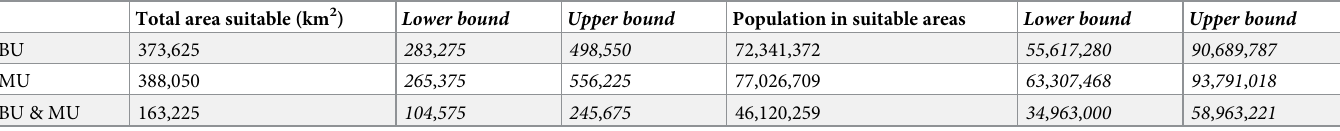
Table 2. Total area predicted suitable and population in areas at risk for Buruli ulcer, M. ulcerans, and both, in Africa. Total area suitable (km 2 )